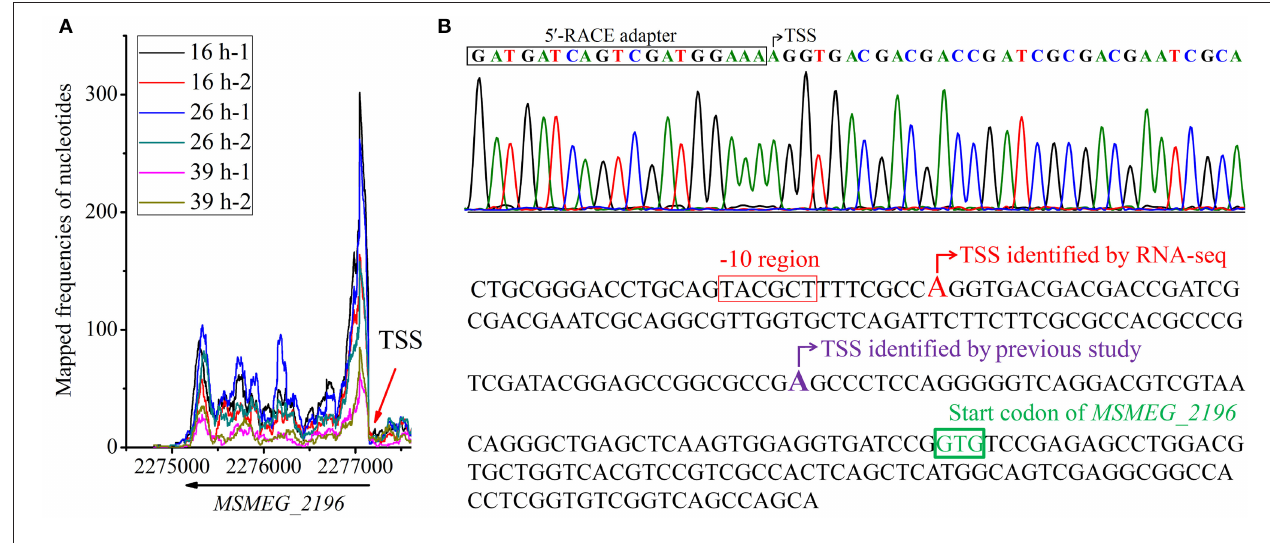
FIGURE 5 | Identification of MSMEG_2196 TSS. (A) Whole view of transcriptional maps of MSMEG_2196-2199 loci. (B) TSS of MSMEG_2196 identified by 5 ′ -RACE in this study. (C) Comparison of TSS of MSMEG_2196 identified by our RNA-seq data with that previously reported ( Bharati et al., 2013). The new identified TSS is colored in red, and the putative − 10 motif is marked in rectangle. The previously identified TSS is colored in purple, however, no conserved − 10 motif can be found.